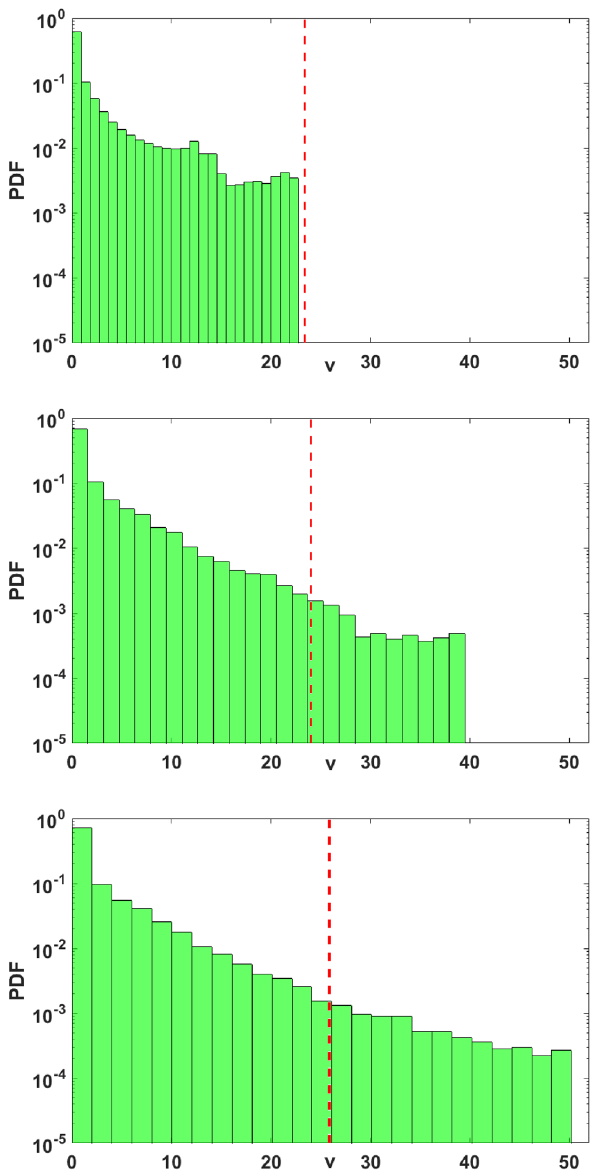
µ + 7 σ is denoted by vertical red dashed